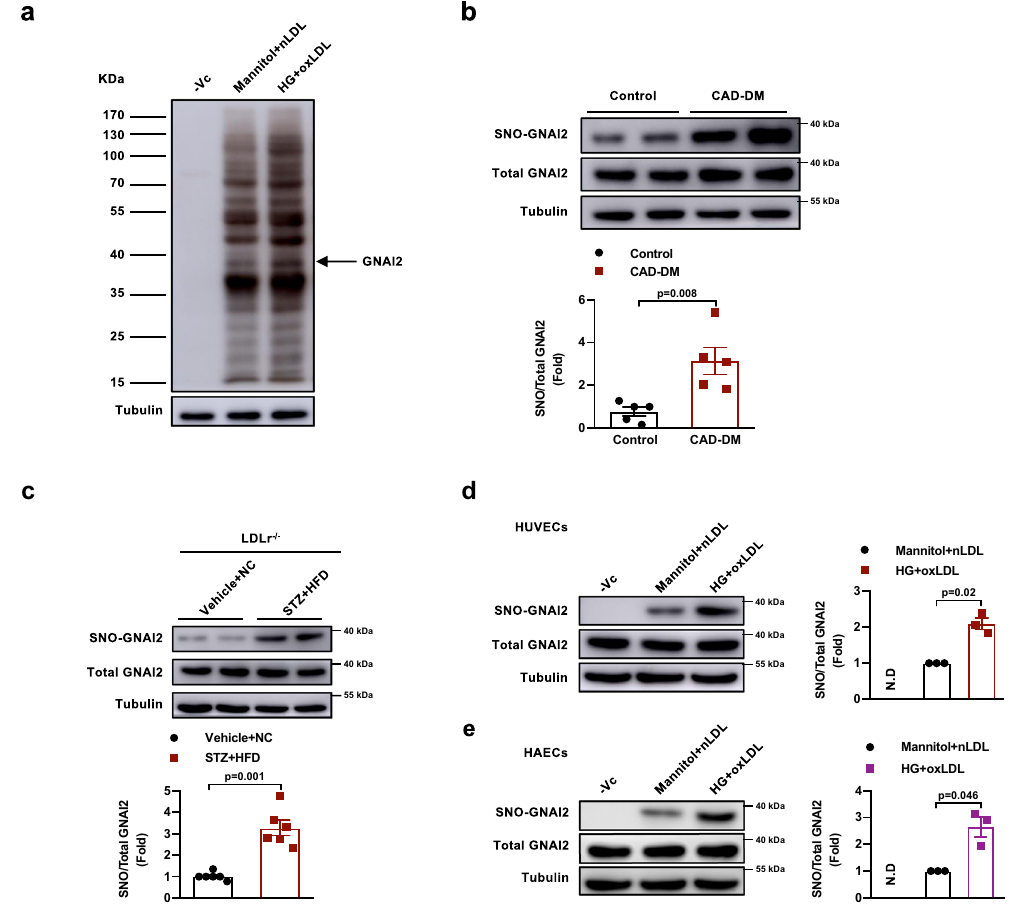
Fig. 1 S-nitrosylation of GNAI2 is signi fi cantly higher in diabetes-accelerated atherosclerosis in vitro and in vivo. a A biotin-switch assay detected protein S-nitrosylation in HUVECs treated with Mannitol + nLDL or HG (25 mmol/L) and oxLDL (50 μ g/mL). One independent experiment was performed. b S-nitrosylation of GNAI2 is signi fi cantly higher in coronary arteries of diabetic patients with CAD. The level of SNO-GNAI2 was quanti fi ed with total- GNAI2 and normalized to Control patients. n = 5 distinct samples for each group. c S-nitrosylation of GNAI2 is increased in the aortas of LDLr − / − mice treated with STZ and HFD. The level of SNO-GNAI2 was quanti fi ed with total-GNAI2 and normalized to Vehicle + NC mice. n = 6 distinct samples for each group. d S-nitrosylation of GNAI2 is markedly increased in HUVECs treated with HG and oxLDL for 24 h. The level of SNO-GNAI2 was quanti fi ed with total-GNAI2 and normalized to Mannitol + nLDL-treated cells. n = 3 distinct samples for each group. N.D represents no detected. e S-nitrosylation of GNAI2 is signi fi cantly increased in HAECs treated with HG and oxLDL for 24 h. The level of SNO-GNAI2 was quanti fi ed with total-GNAI2 and normalized to Mannitol + nLDL-treated HAECs. n = 3 distinct samples for each group. N.D represents no detected. Data are represented as the Mean ± SEM. Unpaired two-tailed Student ’ s t -test was used for statistical analysis. Source data are provided as a Source Data fi